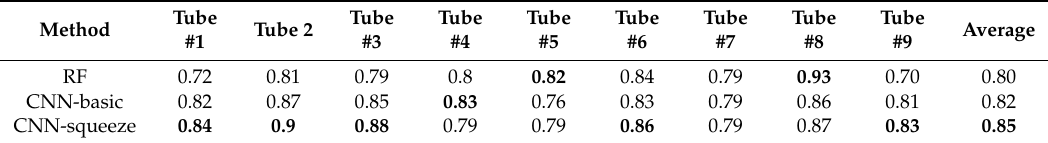
Table 4. Pearson correlation (R) as evaluated by 9-fold